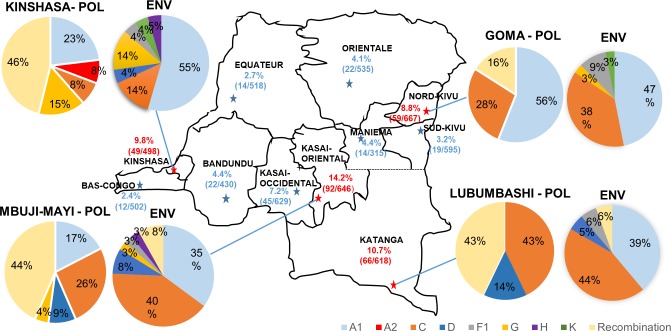
HIV-1 prevalence and regional distribution of HIV-1 variants detected in the DRC.The four cities with highest prevalence of HIV infection are indicated by red stars ★. Pie charts represent the proportion of each HIV-1 subtype as determined by pol and env gene sequences in these four locations, and the different clades were color coded as shown in the figure. Prevalence in other cities is indicated by blue stars ★.